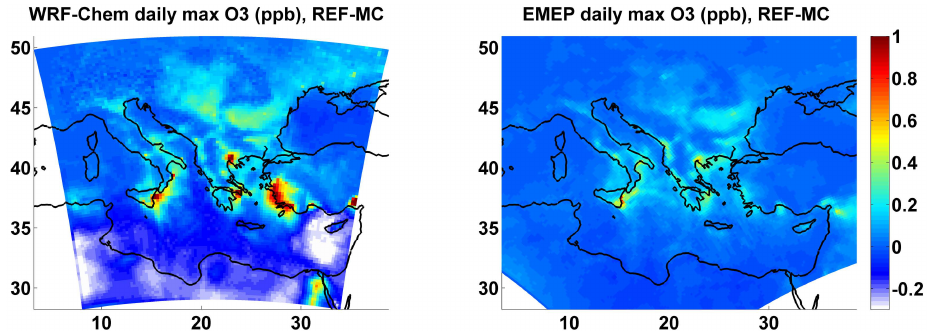
Fig. 13. Change in daily maximum near-surface ozone (ppbv) due to high temperatures (above 28 ◦ C) in the chemistry computations (REF- MC), calculated by WRF-Chem (left) and EMEP MSC-W (right) averaged over the summer (JJA)